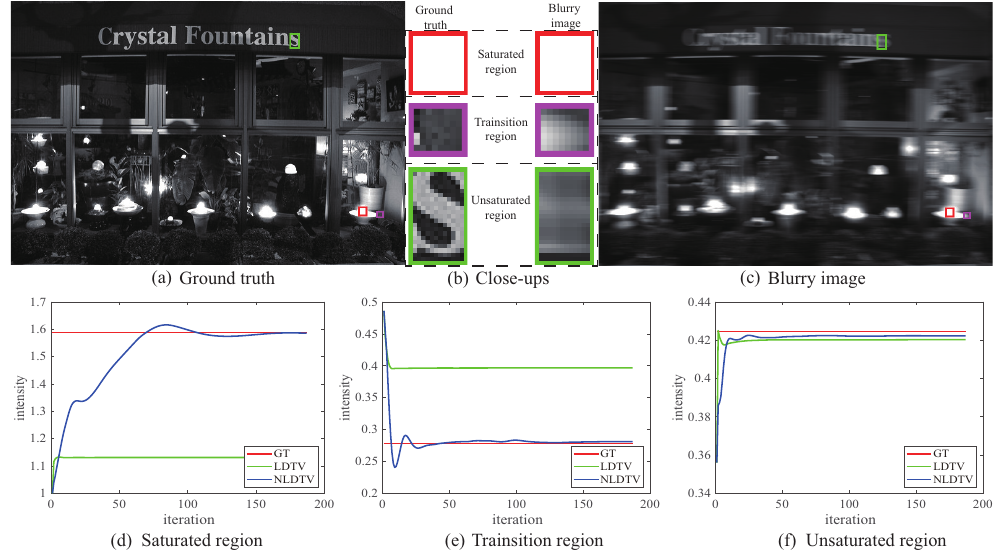
Figure 2. Tracking the average intensity changes of different regions with respect to iteration numbers. Ground-truth and blurry images with saturated, transition, and unsaturated regions marked in boxes are presented in ( a , c ). ( b ) is the close-ups of the marked regions, whose first column shows the close- ups of the ground truth and the second ones are the close-ups of the blurry image. The second row presents the average intensity changes of the above three regions ( d ) saturated region, ( e ) transition region, and ( f ) unsaturated region with respect to the iteration numbers. Note that GT means the ground-truth intensity. The nonlinear method approaches the ground truth for different regions while the linear method does